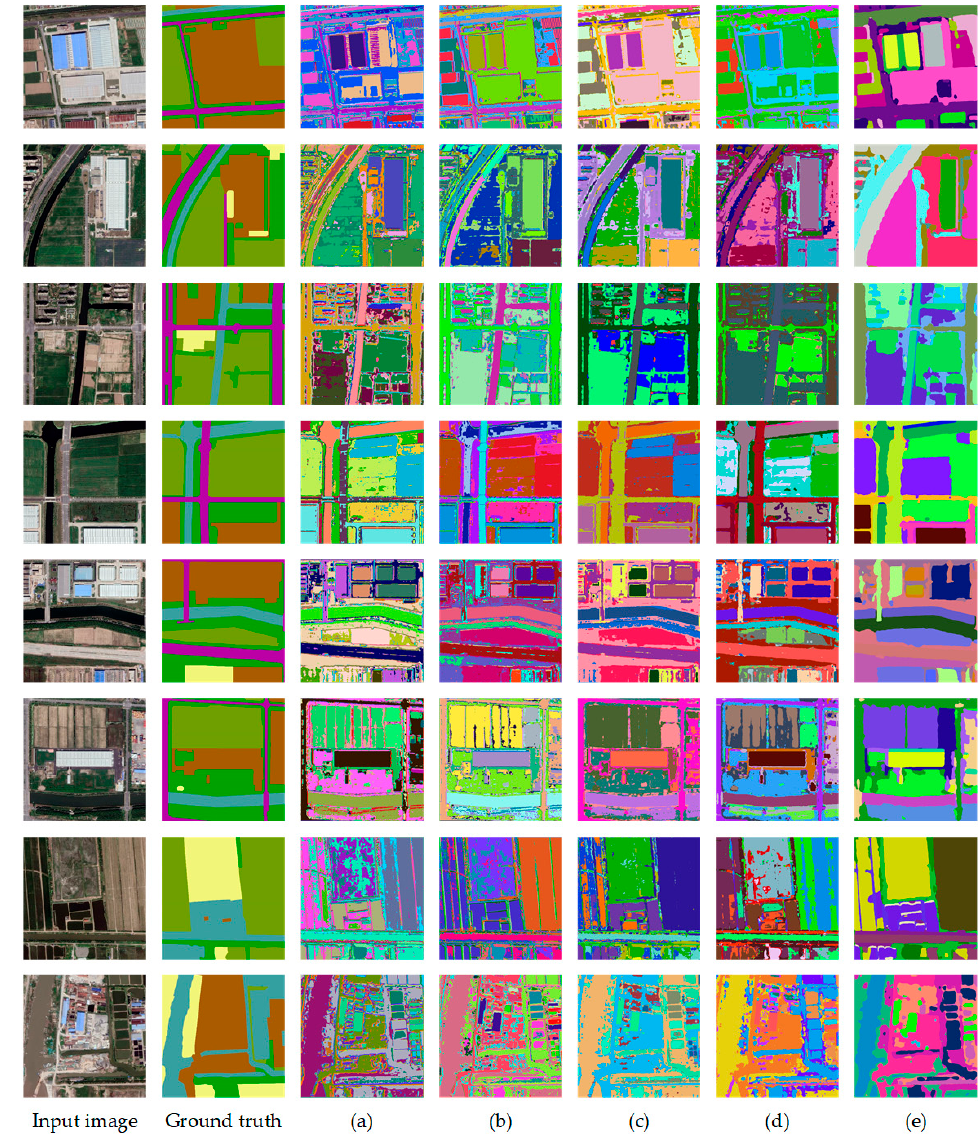
Figure 6. Representative examples of unsupervised remote sensing image segmentation results on Shanghai dataset: ( a ) gPb, ( b ) UCM, ( c ) BackProp, ( d ) DFC, ( e ) our CCT.